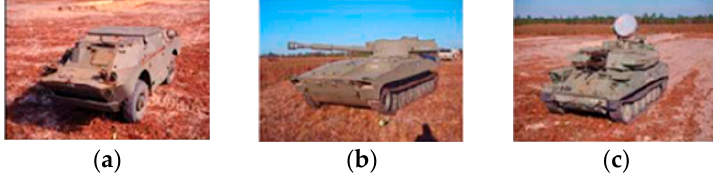
Figure 20. The optical images of three targets in large depression angle experiments. ( a ) BRDM2; ( b ) 2S1; ( c ) ZSU234.